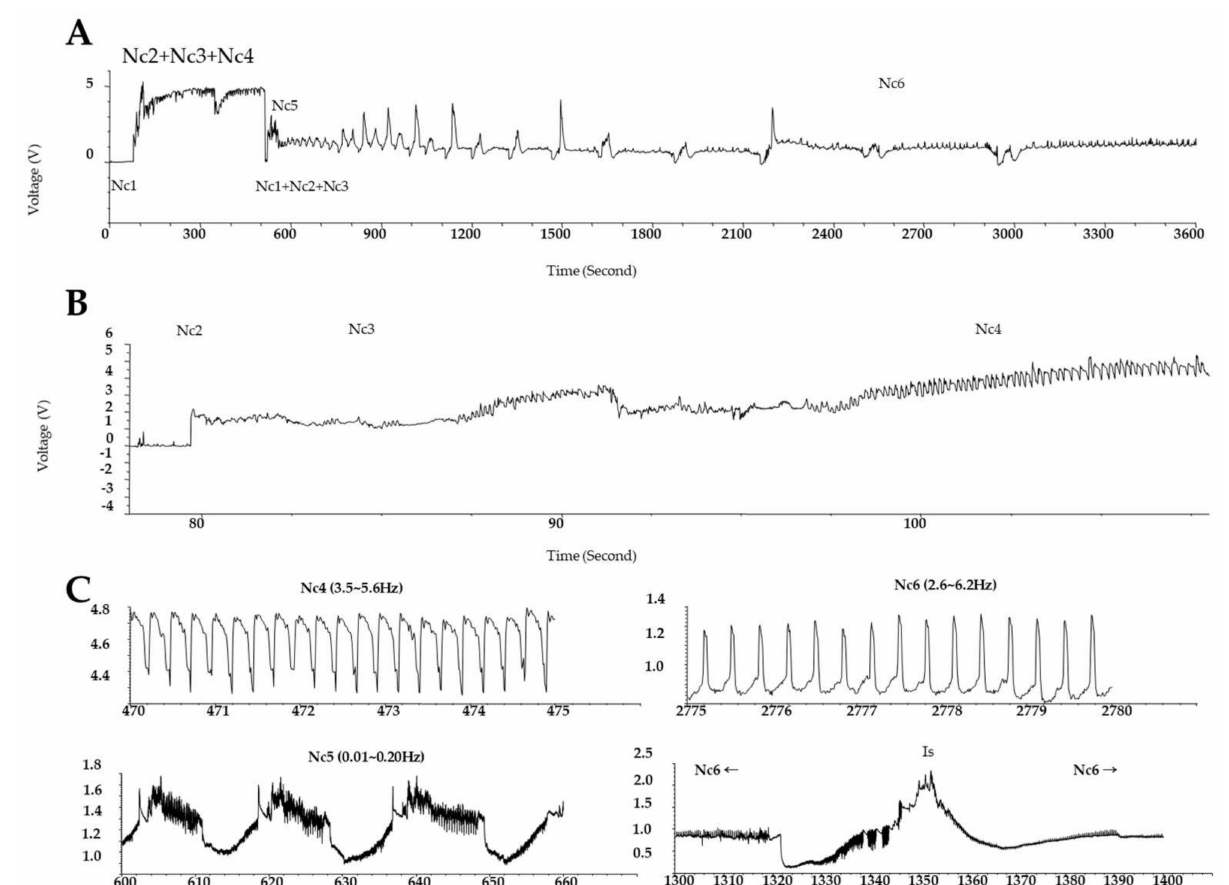
Figure 1. Electrical penetration graph (EGP) showing the feeding patterns of green rice leafhopper over time. EPG of GRH reared ( A ) on Ilpum (GRH-susceptible) and ( B ) on near-isogenic line (NIL) harboring Grh1 locus; ( C ) frequencies of wave- forms (Nc1 to Nc6). Typically, to take up phloem sap, waveforms are categorized as follows: Nc1 → Nc2 → Nc3 → Nc5 → Nc6. Nc1 means non-probing, Nc2 indicates the penetration of stylet into host, Nc3 signifies path and salivation, Nc4 represents xylem feeding, Nc5 shows salivation or physical activity in the phloem, and Nc6 represents phloem sap sucking. Nc2–Nc6 indicate the time to reach the stylet to phloem and ready to take up nutrients from the phloem. Accumulated Nc6 means the accumulative time to take up nutrients from the phloem. Shingwang and NIL showed similar patterns in Nc2–Nc6, accumulated Nc6, and